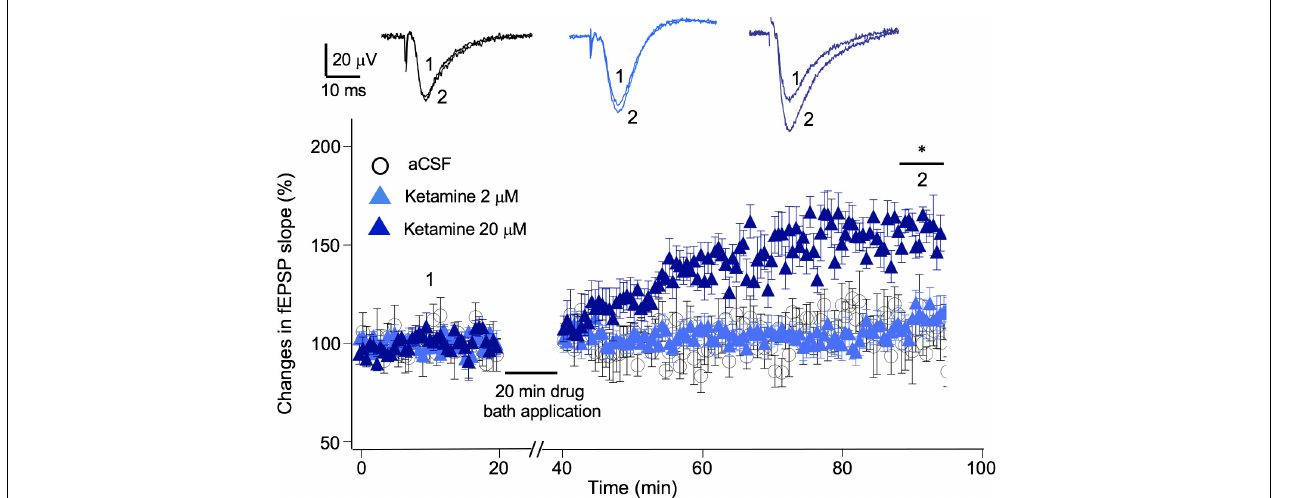
FIGURE 4 | Ketamine’s concentration-dependent effect on synaptic plasticity. Time course and magnitude of synaptic plasticity in hippocampal CA1 region induced by bath applied ketamine for 20 min at concentrations of 0 ( p > 0.05), 2 µ M ( p > 0.05), and 20 µ M (* p < 0.05; One-way ANOVA followed by post hoc Tukey tests). The magnitude of synaptic potentiation was quantified by normalizing fEPSP slope to baseline pre-ketamine responses. Inset shows representative traces of fEPSPs before and after ketamine application.